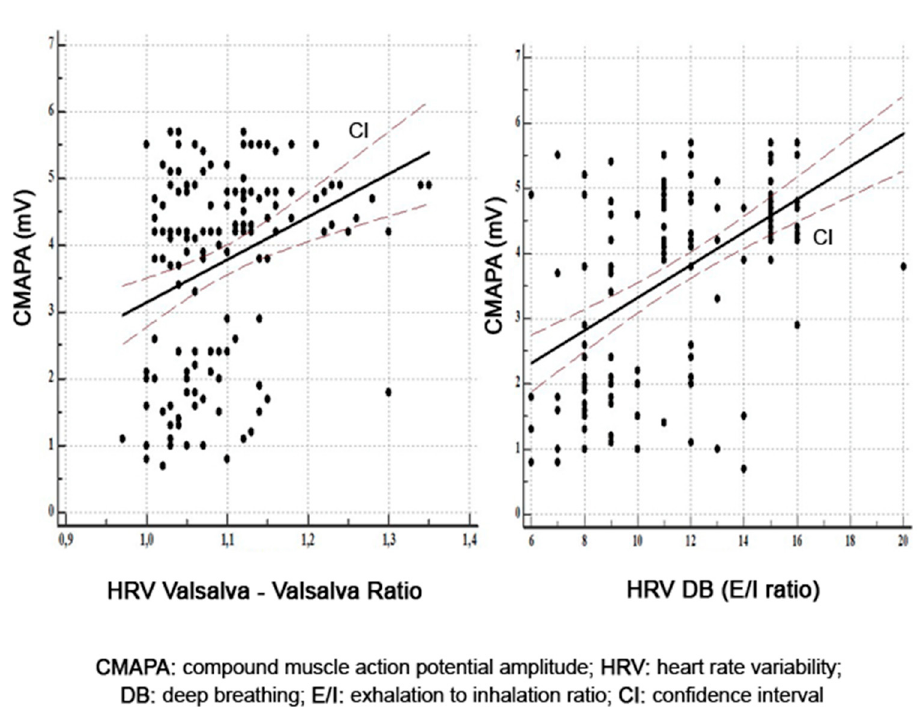
Figure 2. Correlations between amplitude of motor response in peroneal nerve and HRV Valsalva and HRV DB.